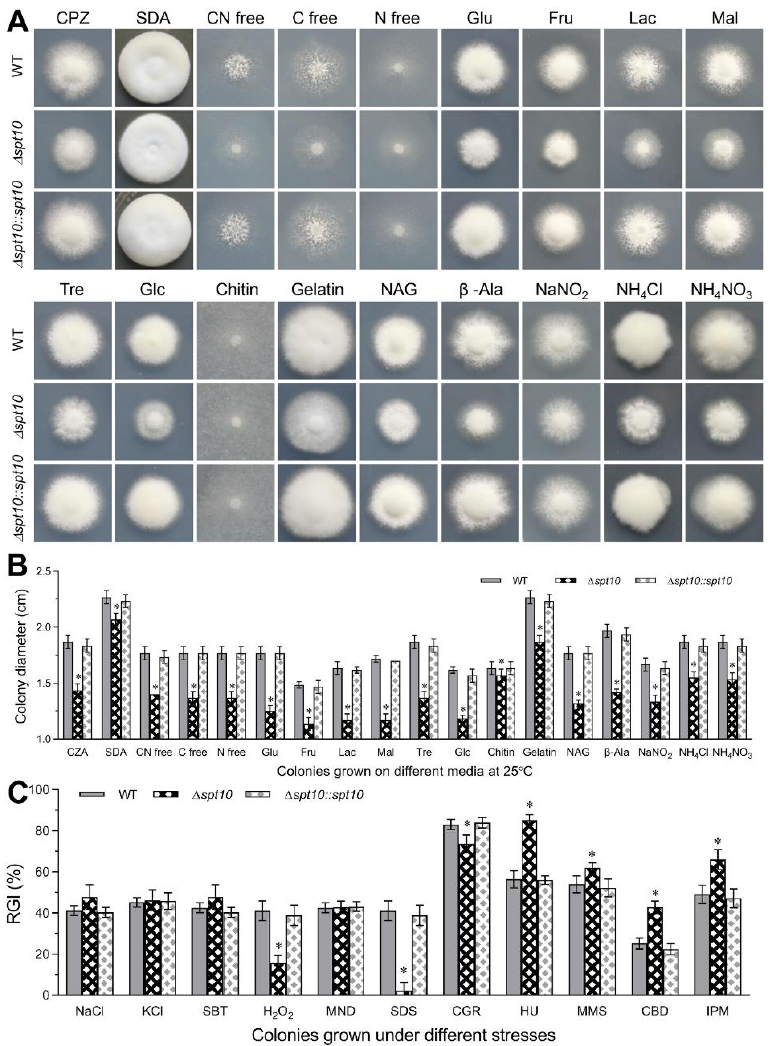
Figure 3. Contribution of BbSpt10 to carbon/nitrogen utilization. ( A , B ) Representative images and measured colony diameters after 8 d cultivation at 25 C on indicated media as detailed in the Materials and Methods section. Key carbon sources: Glu, glucose; Fru, fructose; Lac, lactose; Mal, maltose; Tre, trehalose; Glc, glycerol; chitin; gelatin. Key nitrogen sources: β-Alanine (β-Ala), N- Acetylglucosamine (NAG), NaNO 2 , NH 4 Cl, or NH 4 NO 3 . Additional media: carbon (C free), nitrogen (N free), or both (CN free). ( C ) Relative growth inhibition (RGI, as compared to wild type) of fungal colonies grown at 25 C for 8 d on CZA supplemented with NaCl (0.4 M), KCl (0.4 M), sorbitol (SBT; 0.6 M), H 2 O 2 (2 mM), menadione (MND; 0.02 mM), SDS (100 μg/mL), Congo red (CGR; 10 μg/mL), hydroxyurea (HU; 10mM), methyl methanesulfonate (MMS, 0.05%), carbendazim (CBD, 5 μg mL –1 ), and iprodione metabolite(IPM, 10 μg mL –1 ). All colonies were initiated by spotting aliquots (1 μL) of 1 × 10 6 conidia/mL suspension in the center of plates. All experiments were performed in triplicate. Error bars = ± SD. Asterisks indicate significantly different from unmarked (Tukey’s HSD, * indicates p < 0.05). 3.4. Impact of BbSpt10 Loss on Cell Cycle and Hyphal Septation Microscopic examination of the hyphal cells collected from the 72 h Sabouraud dex- trose broth (SDB) cultures and stained with the cell wall-specific dye calcofluor white re- vealed altered hyphal septation patterns in the BbSpt10 mutant strain, as compared to control strains (Figure 4A). Hyphal cells of BbSpt10 were significantly shorter (~28%, p < 0.01) than those of control strains, but did not show any changes in terms of cell width (Figure 4A,B). In order to examine potential effects of Spt10 on cell cycle progression, the